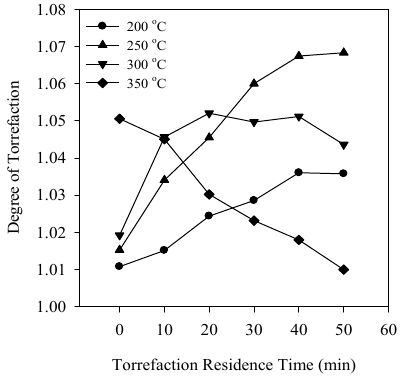
Figure 4. Degree of torrefaction of torrefied samples as a function of the torrefaction residence time.